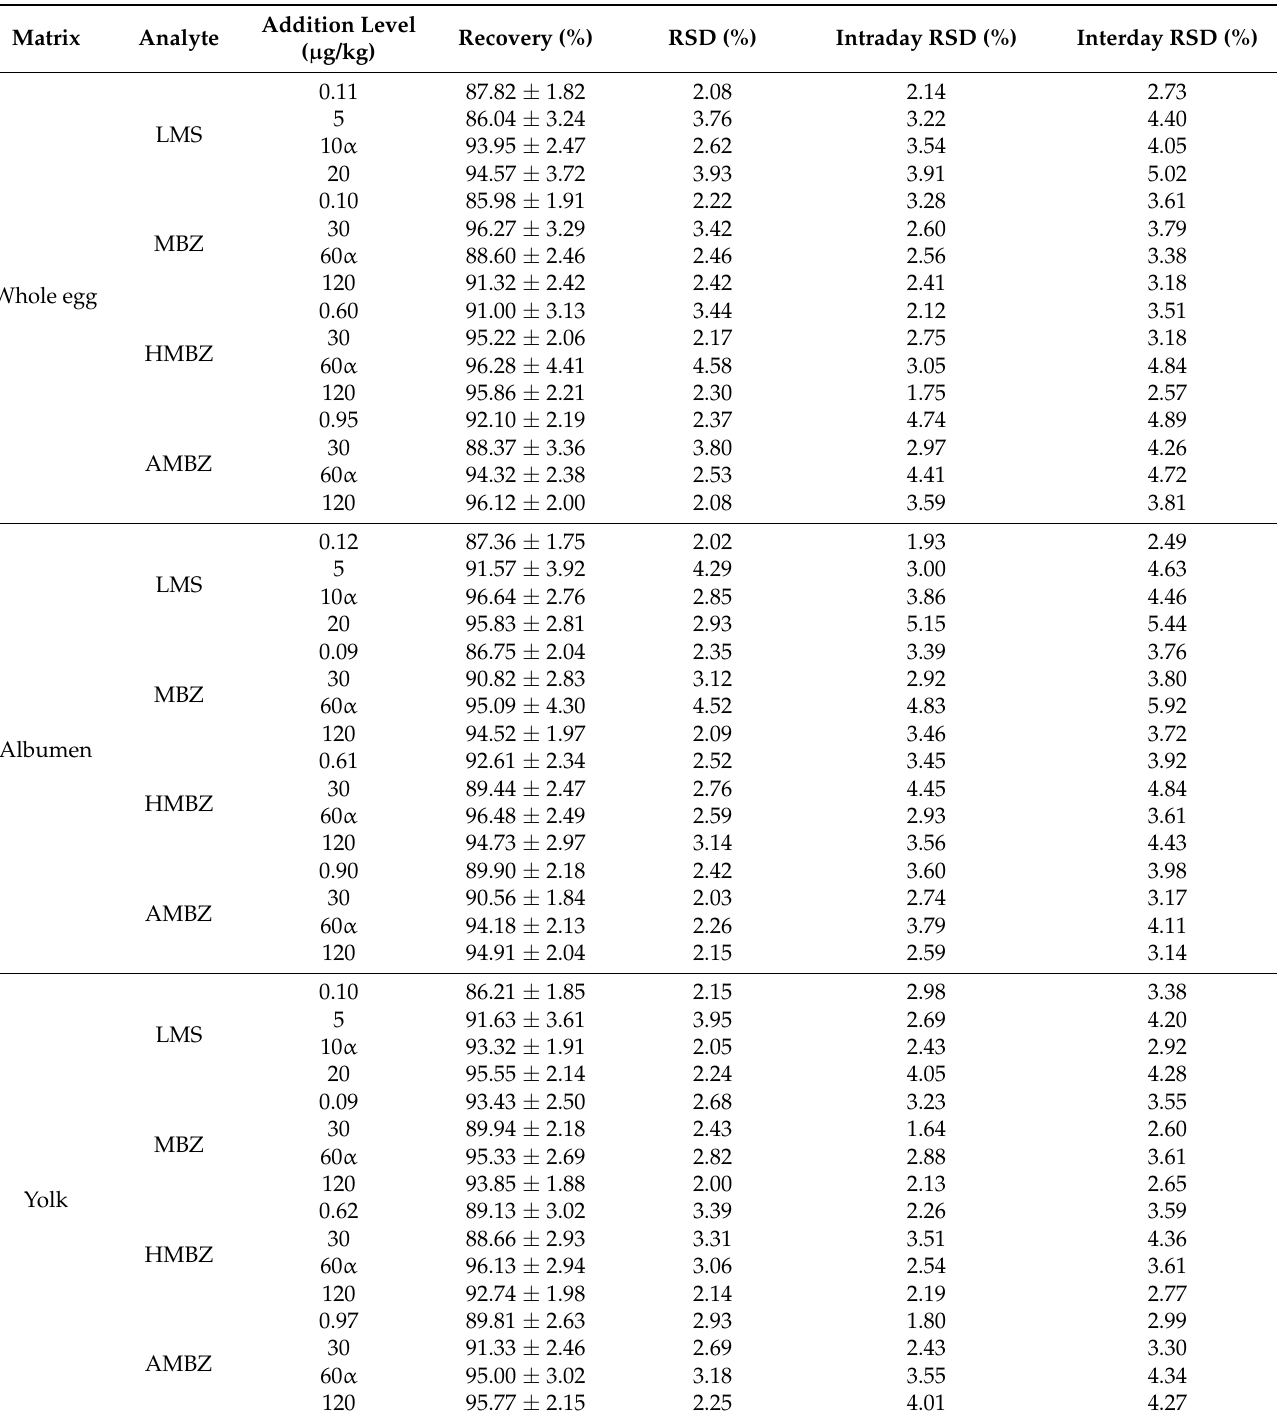
Table 7. Recovery and precision of LMS, MBZ, HMBZ, and AMBZ added to blank goose eggs ( n =